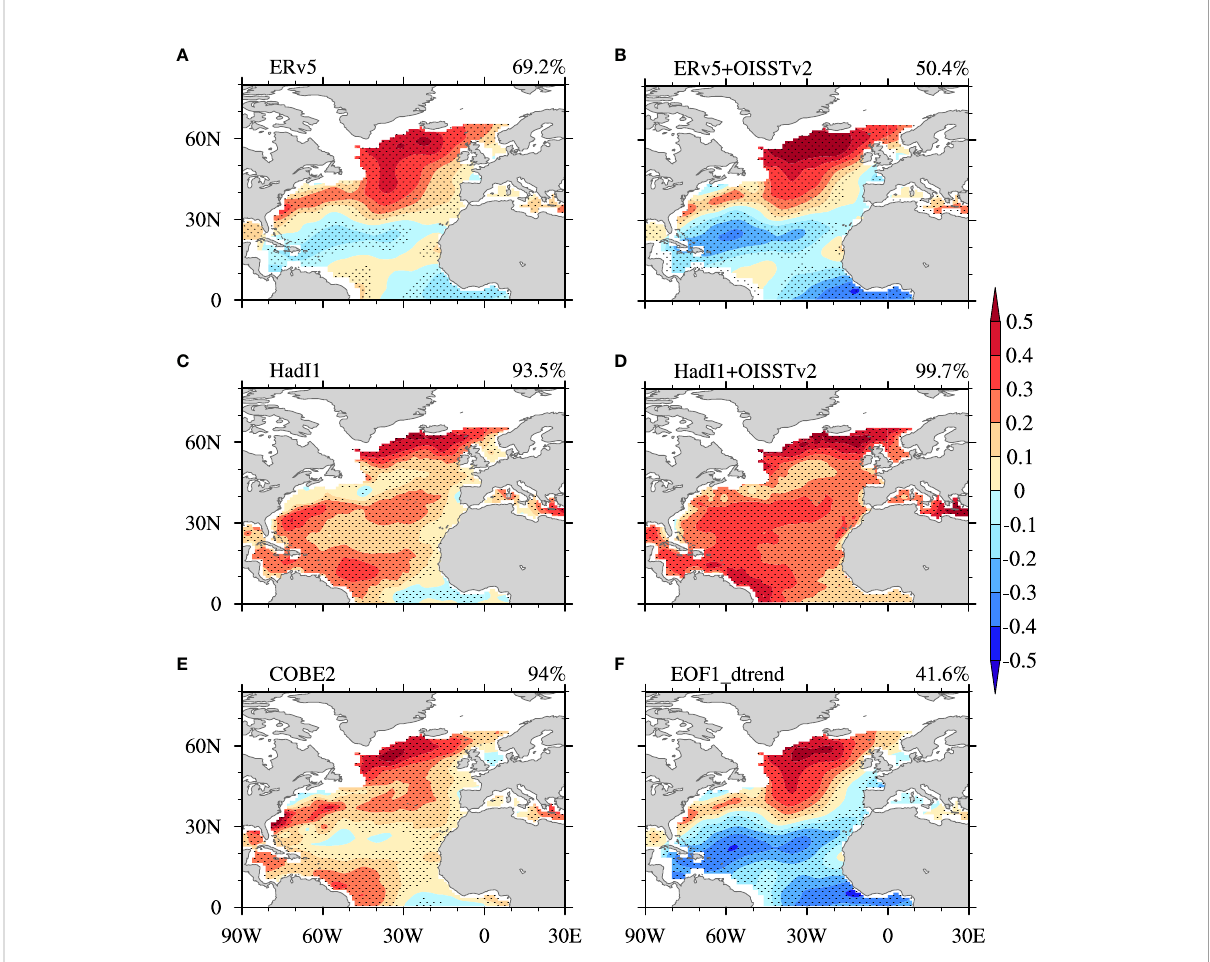
FIGURE 1 Spatial pattern of the AMO extracted by LFCA from different SST datasets over the period 1900 – 2019: (A, C, E) ERv5, HadI1, and COBE2, respectively. (B) ERv5 in 1900 – 1981 and OISSTv2 in 1982 – 2019. (D) HadI1 in 1900 – 1981 and OISSTv2 in 1982 – 2019. (F) Leading mode of LFCA after removing the fi rst leading EOF mode and the principal component (i.e., the inhomogeneous warming trend) over the North Atlantic. The second/third leading low-frequency pattern and component of monthly SSTA in ERv5(COBE2)/HadI1 is the AMO pattern and index, respectively. The AMO CI from each dataset is denoted in the top-right corner of the fi gure. Dots indicate the value passes the 95% signi fi cance level. Unit: